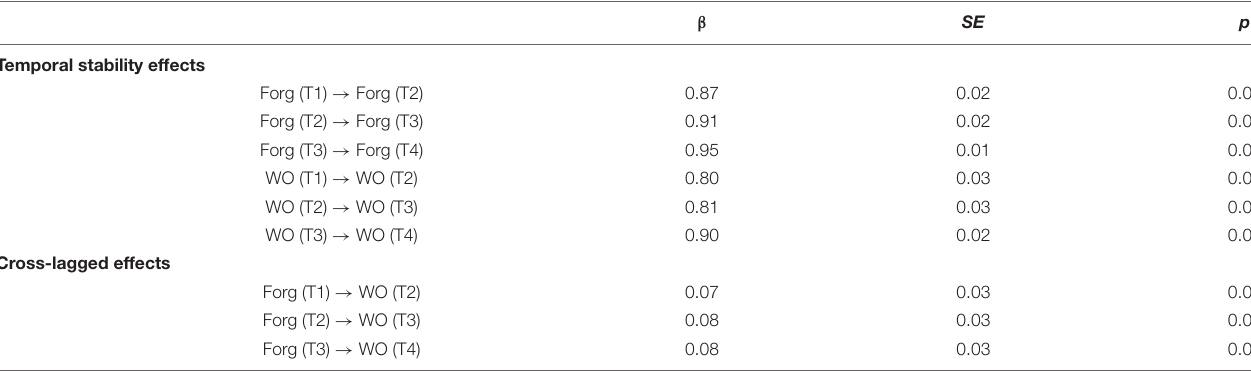
TABLE TA2 | Standardized path coefficients of M 2 a excluding control